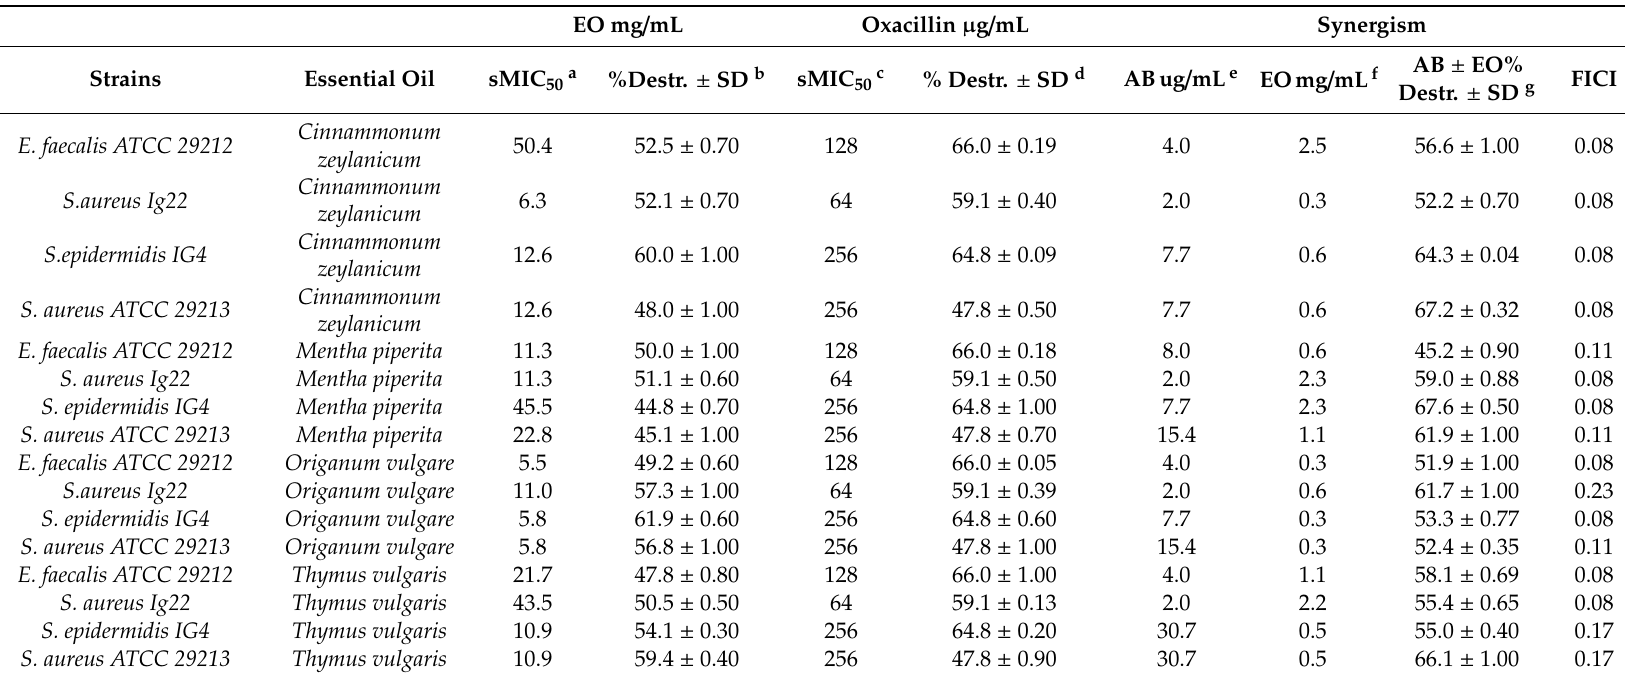
Table 3. Destruction e ff ect of di ff erent EOs alone and in combination with oxacillin on mature